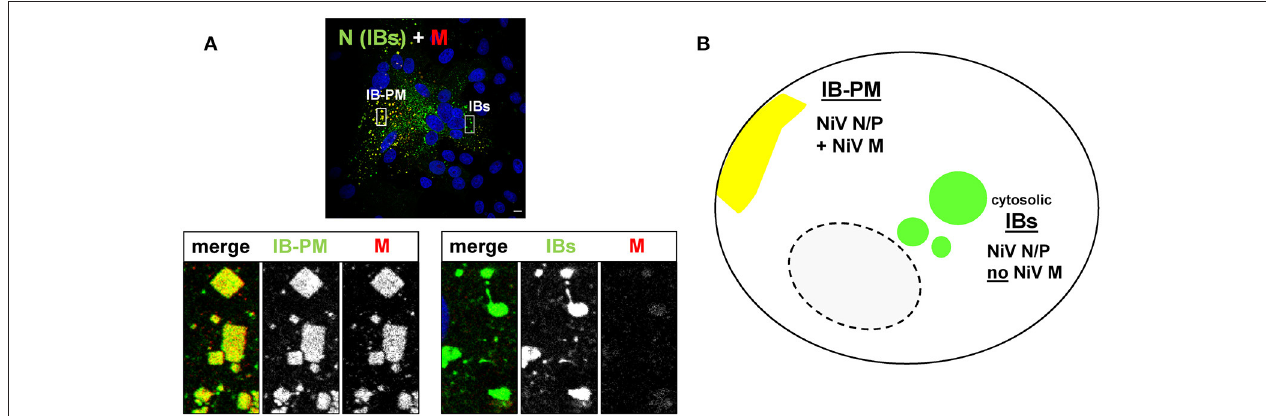
FIGURE 1 | NiV induces the formation of two different inclusion body populations. (A) Vero76 cells were infected with NiV at an MOI of 0.05. 24h p.i. cells were fixed with 4% PFA for 48h and stained with a NiV N antiserum to visualize IBs (green) and with a Zenon-labeled M-specific antiserum to detect the M protein (red). Nuclei were counterstained with DAPI (blue). Images were recorded with a Leica SP5 confocal laser scanning microscope. Scale bar, 10 µ m. The magnified areas in the lower panel display the two different IB types and also show the single channel greyscale images of the labeled proteins. (B) Simplified model of the two different inclusion body populations and their protein composition in NiV infected cells.